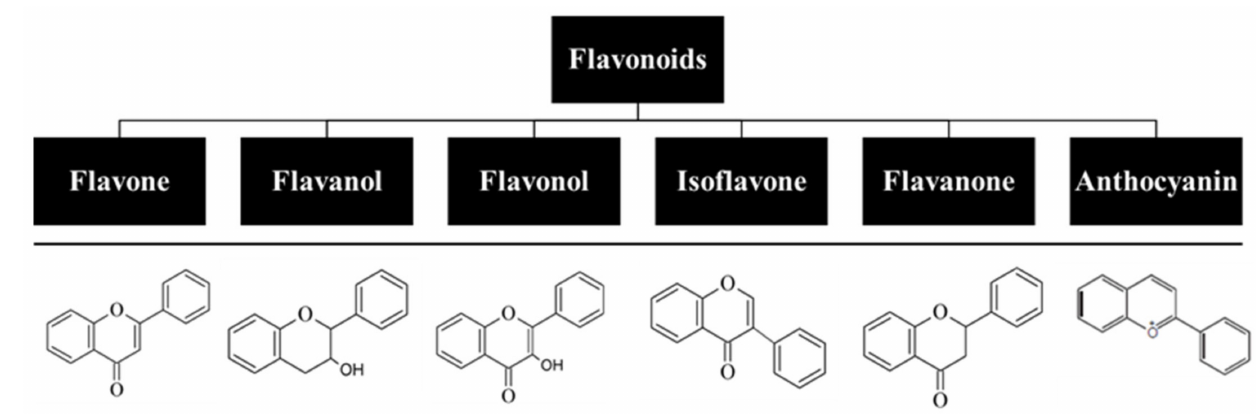
Figure 1. Classification of flavonoids based on their chemical